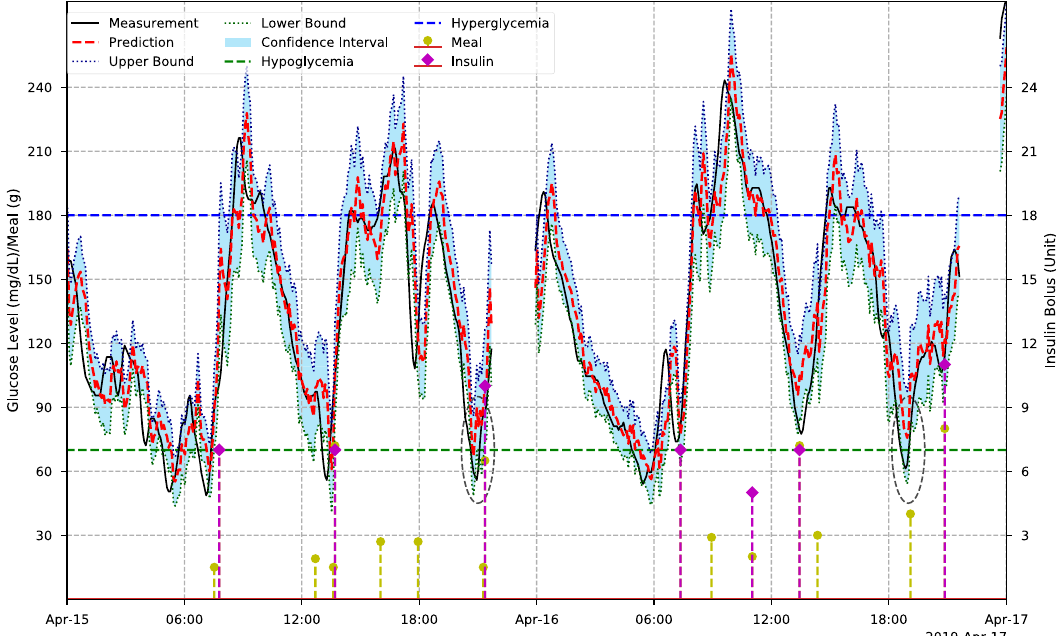
Fig. 5 Two-day period CGM and prediction trajectories of a T1D adult over a 30-minute prediction horizon. The ellipses indicate the hypoglycemic events that are missed by prediction values but detected by the lower